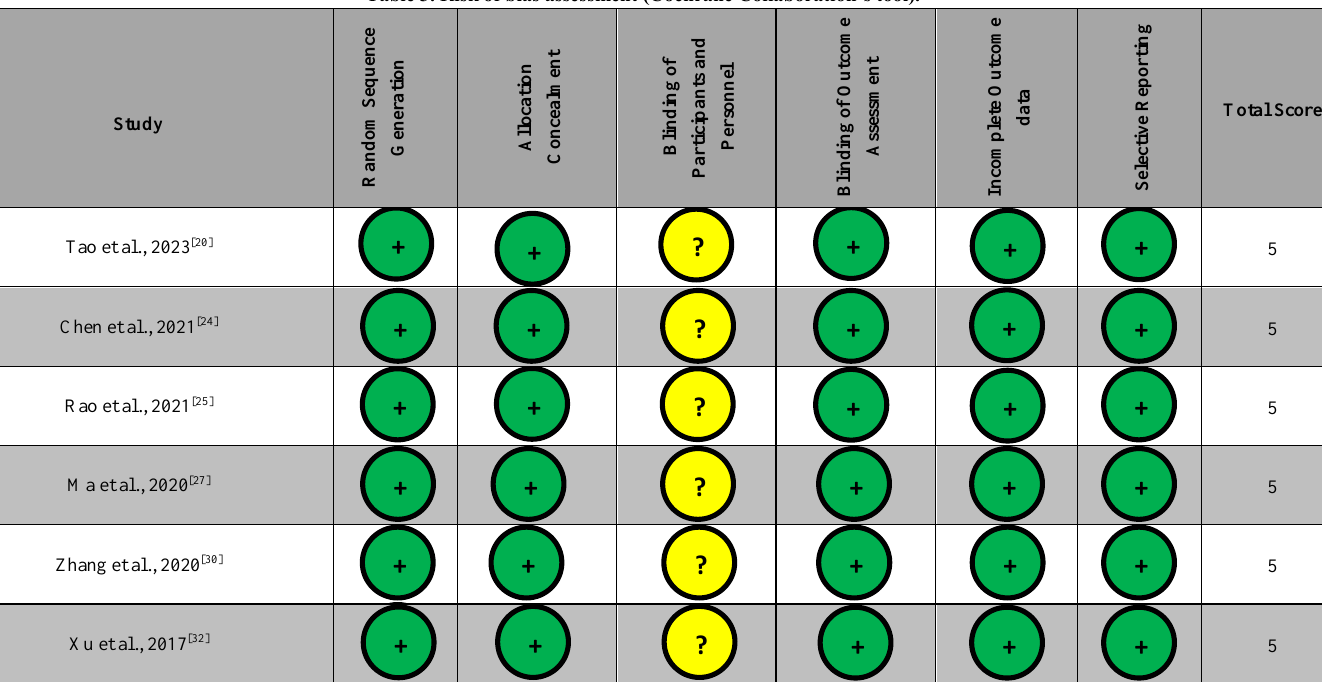
Table 3. Risk of bias assessment (Cochrane Collaboration’s